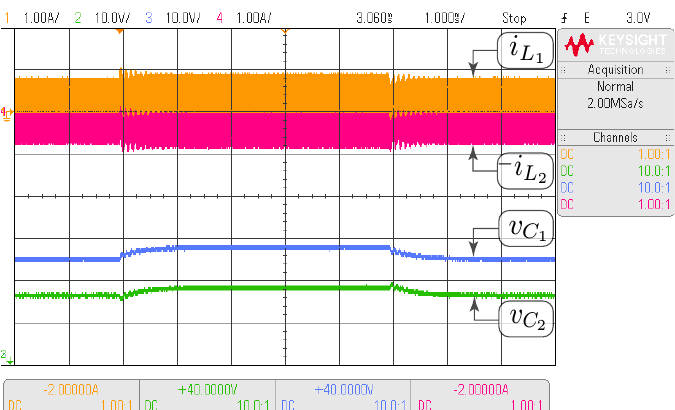
Figure 10. HIL test to validate the proposed model and the simulation of the switched model using PSIM by the ´Cuk converter without coupled inductors shown in Figure 6. CH1: i l